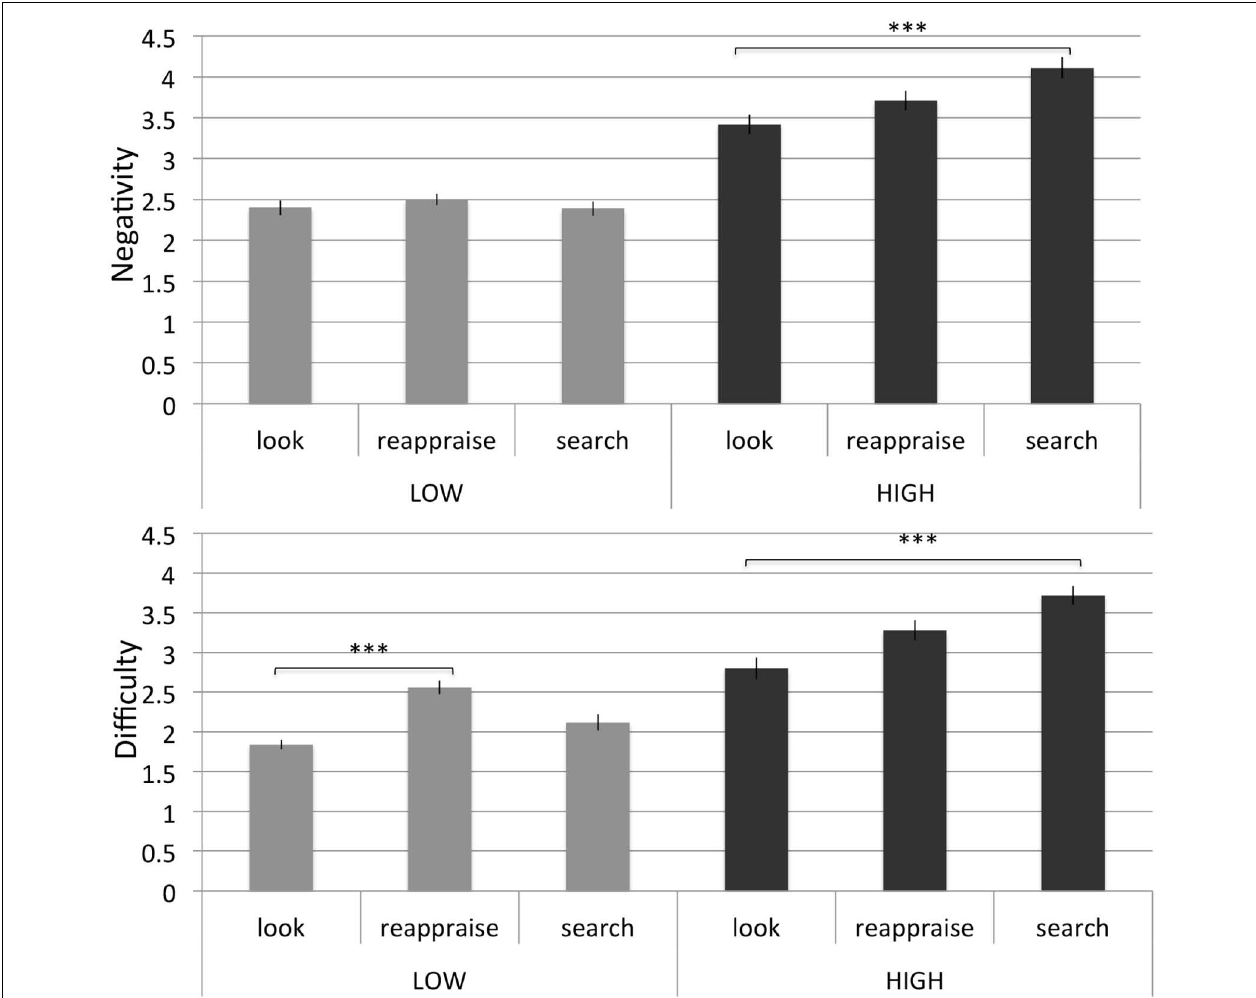
FIGURE 4 | Study 3: mean of negativity and difficulty ratings in low and high imagined negative pictures in the three conditions (“look,”“reappraise,” and “search”), N = 41. * p < 0.05, ** p < 0.01, *** p < 0.001.